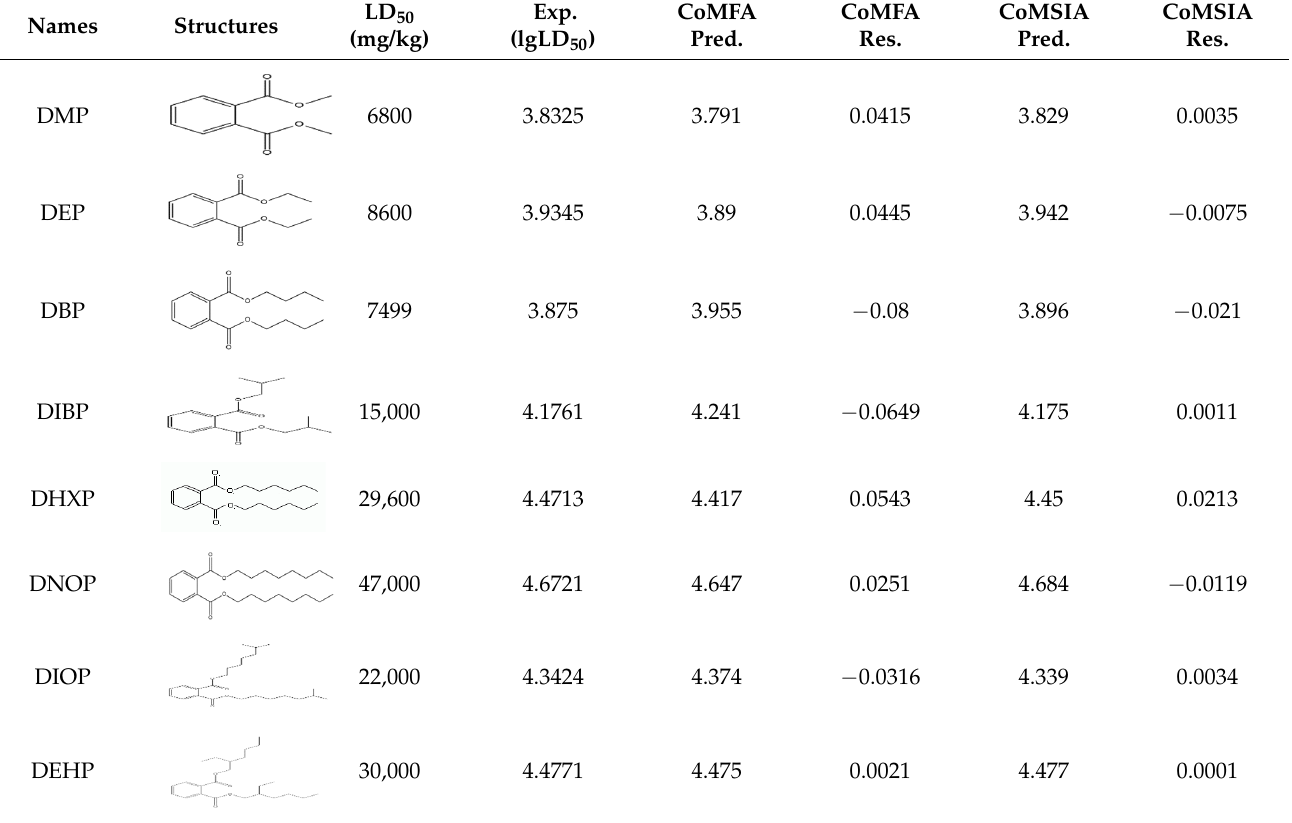
Table 1. Actual value, predicted value and error of 3D-QSAR model of PAEs lgLD 50 .